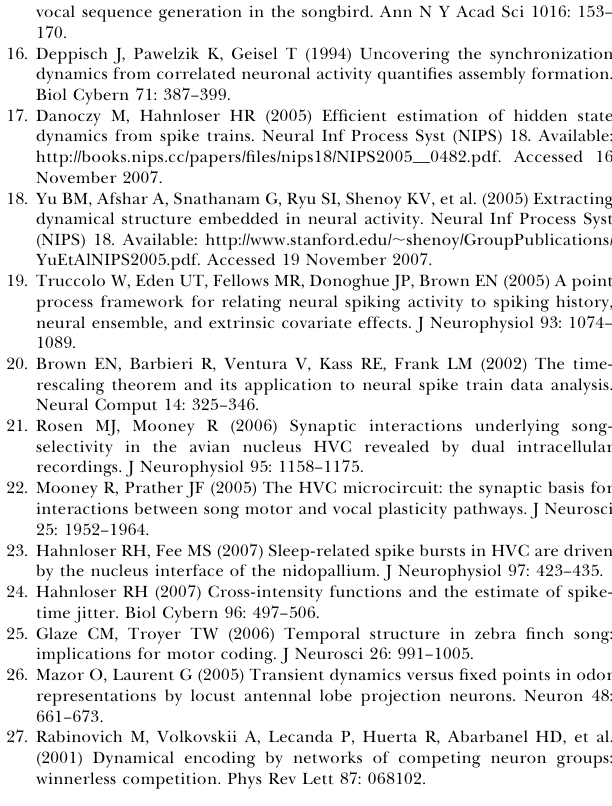
Figure S1. Comparison of Song-Related and Sleep-Related Average ISI pdfs